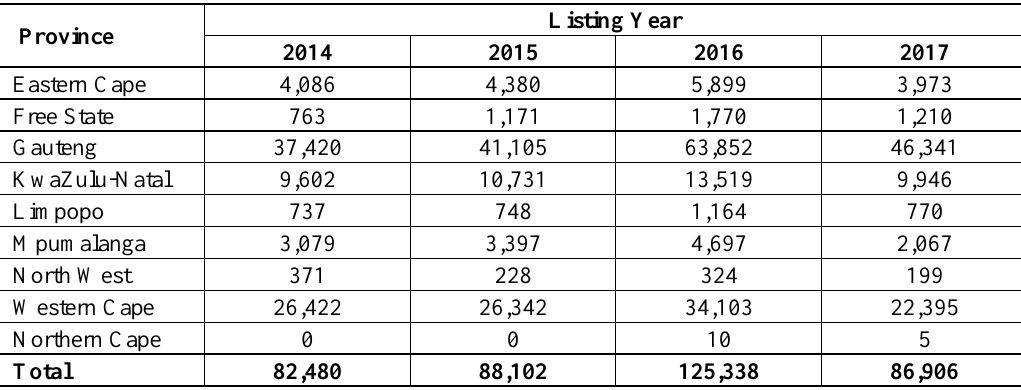
Table 4: Spatial and Temporal Distribution of